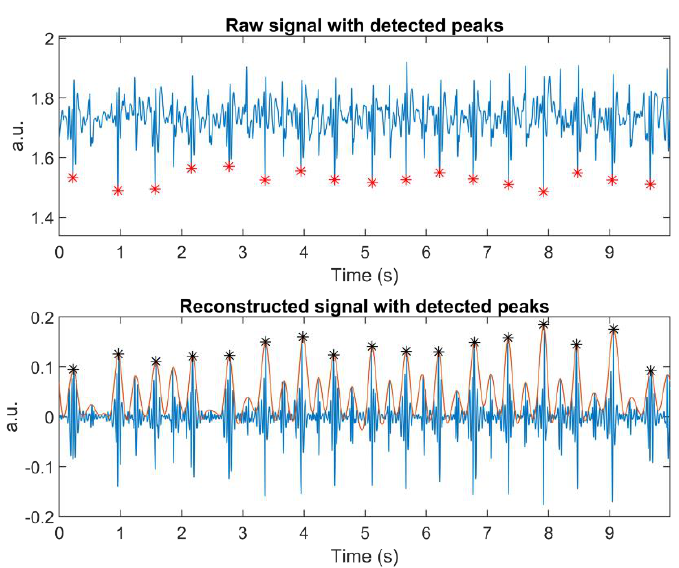
Figure 8. Result from Detect . Wavelet transform guides the determination of peak candidates (*) ( bottom ). The figure shows corrected peak locations (*) ( top ). It is interesting to note here that Detect can follow variations in the inter-beat interval as shown in the beginning of the beat with a larger interval. Table 1. Performance of Both Algorithms on Group #1.